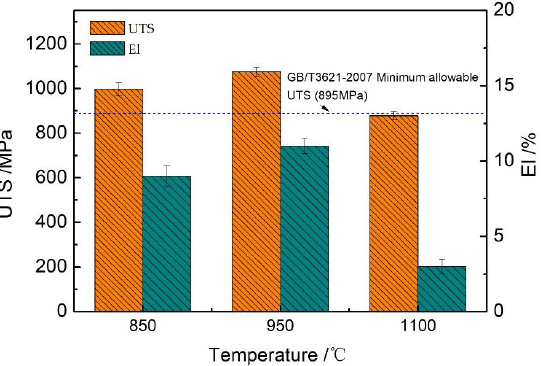
Figure 10. The mechanical properties of Ti-6Al-4V alloy deformed by 90% at different temperatures.